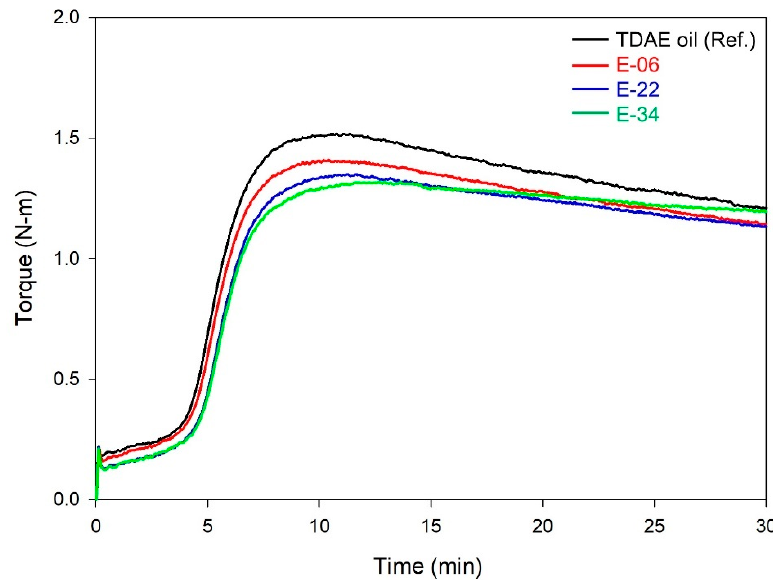
Figure 3. Curing characteristics determined by MDR at 150 °C